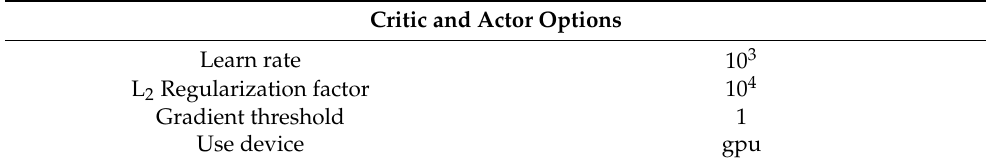
Table 3. The options for the actor and critic.